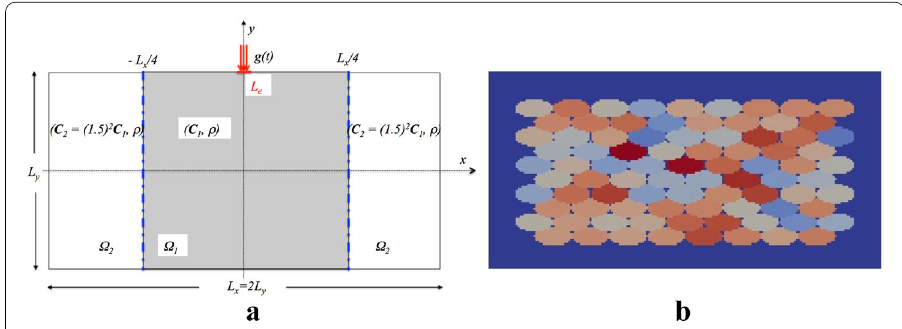
Fig. 5 Studied 2D rectangular elastic domain. a Case with two vertical physical interfaces; b case of polycrystalline material with elliptic